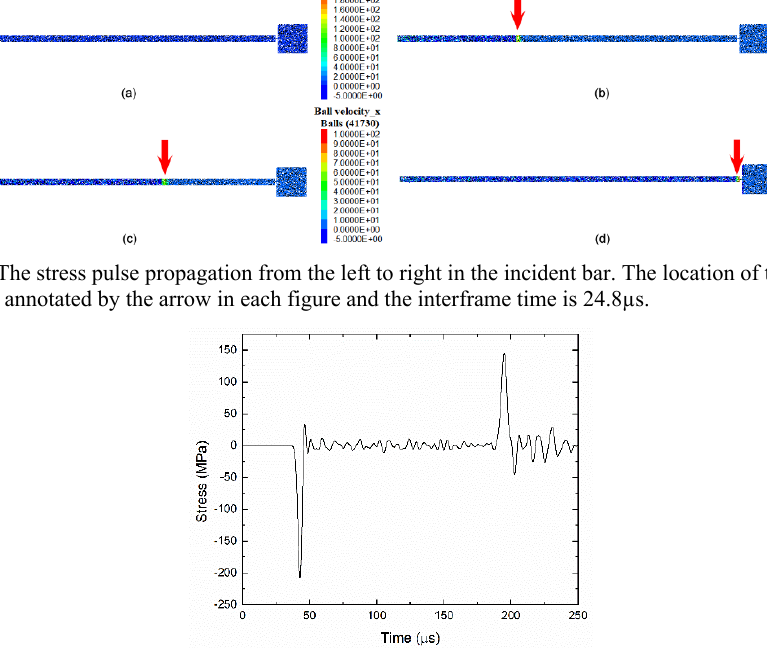
Fig. 3. The incident and reflected stress pulses in the incident